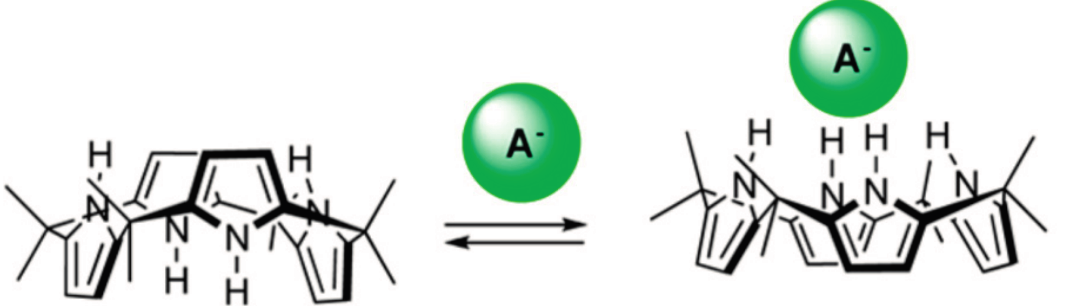
Figure 6. Calix[4]pyrrole in the 1,3-alternate conformation (left side) converts to the cone form by anion binding.